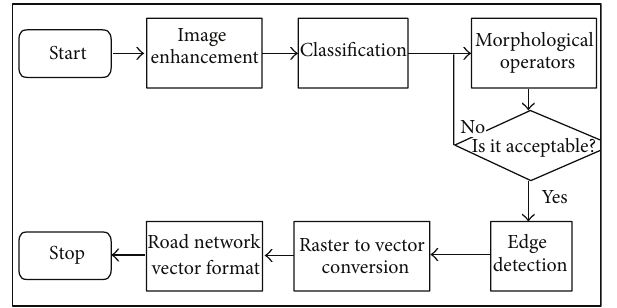
Figure 1: Graph showing the steps necessary to extract road network from high-resolution image.